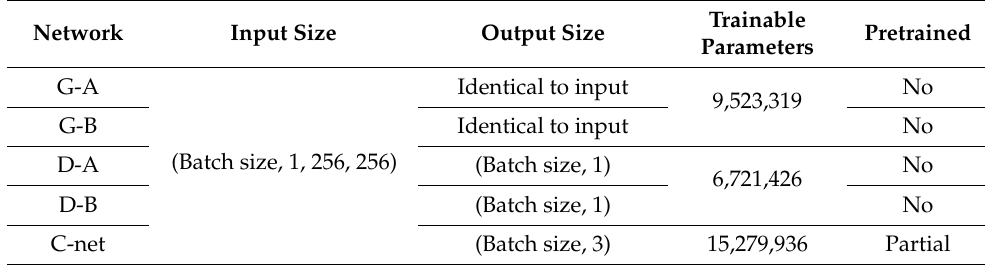
Table 1. The description of each network in the